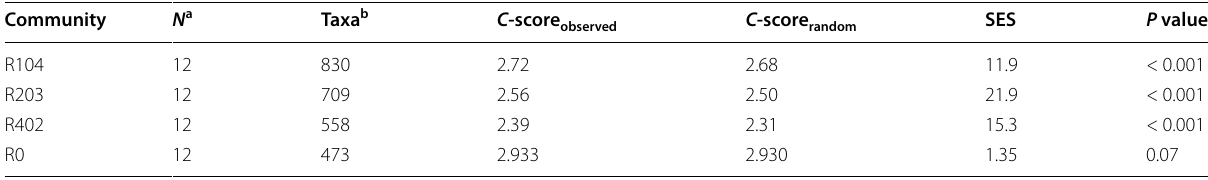
SES standardised effect size, R0 background well, R104 proximal well, R203 intermediate well, R403 distal well a Number of samples in each well b Taxa were filtered to only include those present in abundances (counts)